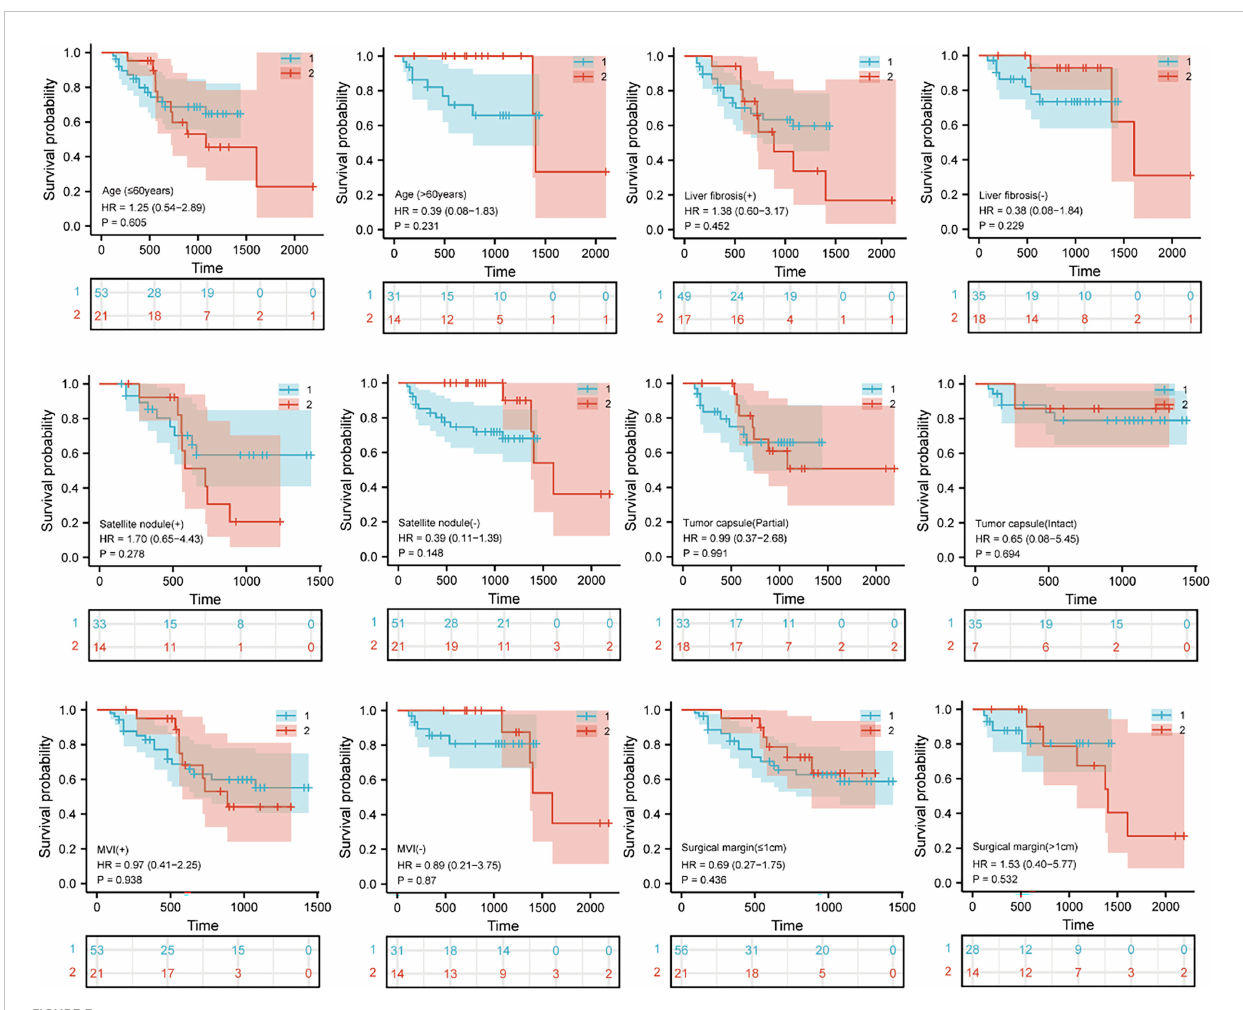
FIGURE 3 Kaplan – Meier curves for Subgroup analysis in patients with hepatocellular carcinoma tumors more than 5 cm and located in the dif fi cult segment after laparoscopic or open liver resection. Overall survival curves after propensity score matching. “ 1 ” represents the open liver resection (OLR). “ 2 ” represents the laparoscopic liver resection